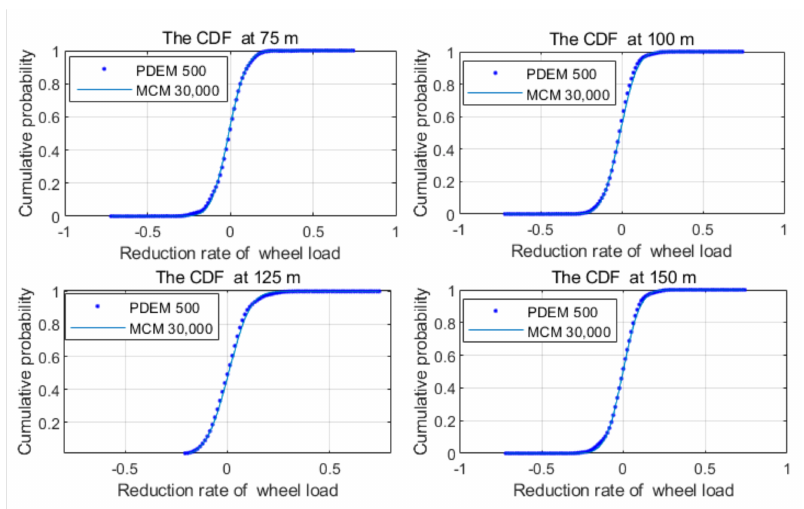
Figure 6. CDF comparison of the reduction rates of wheel loads at different